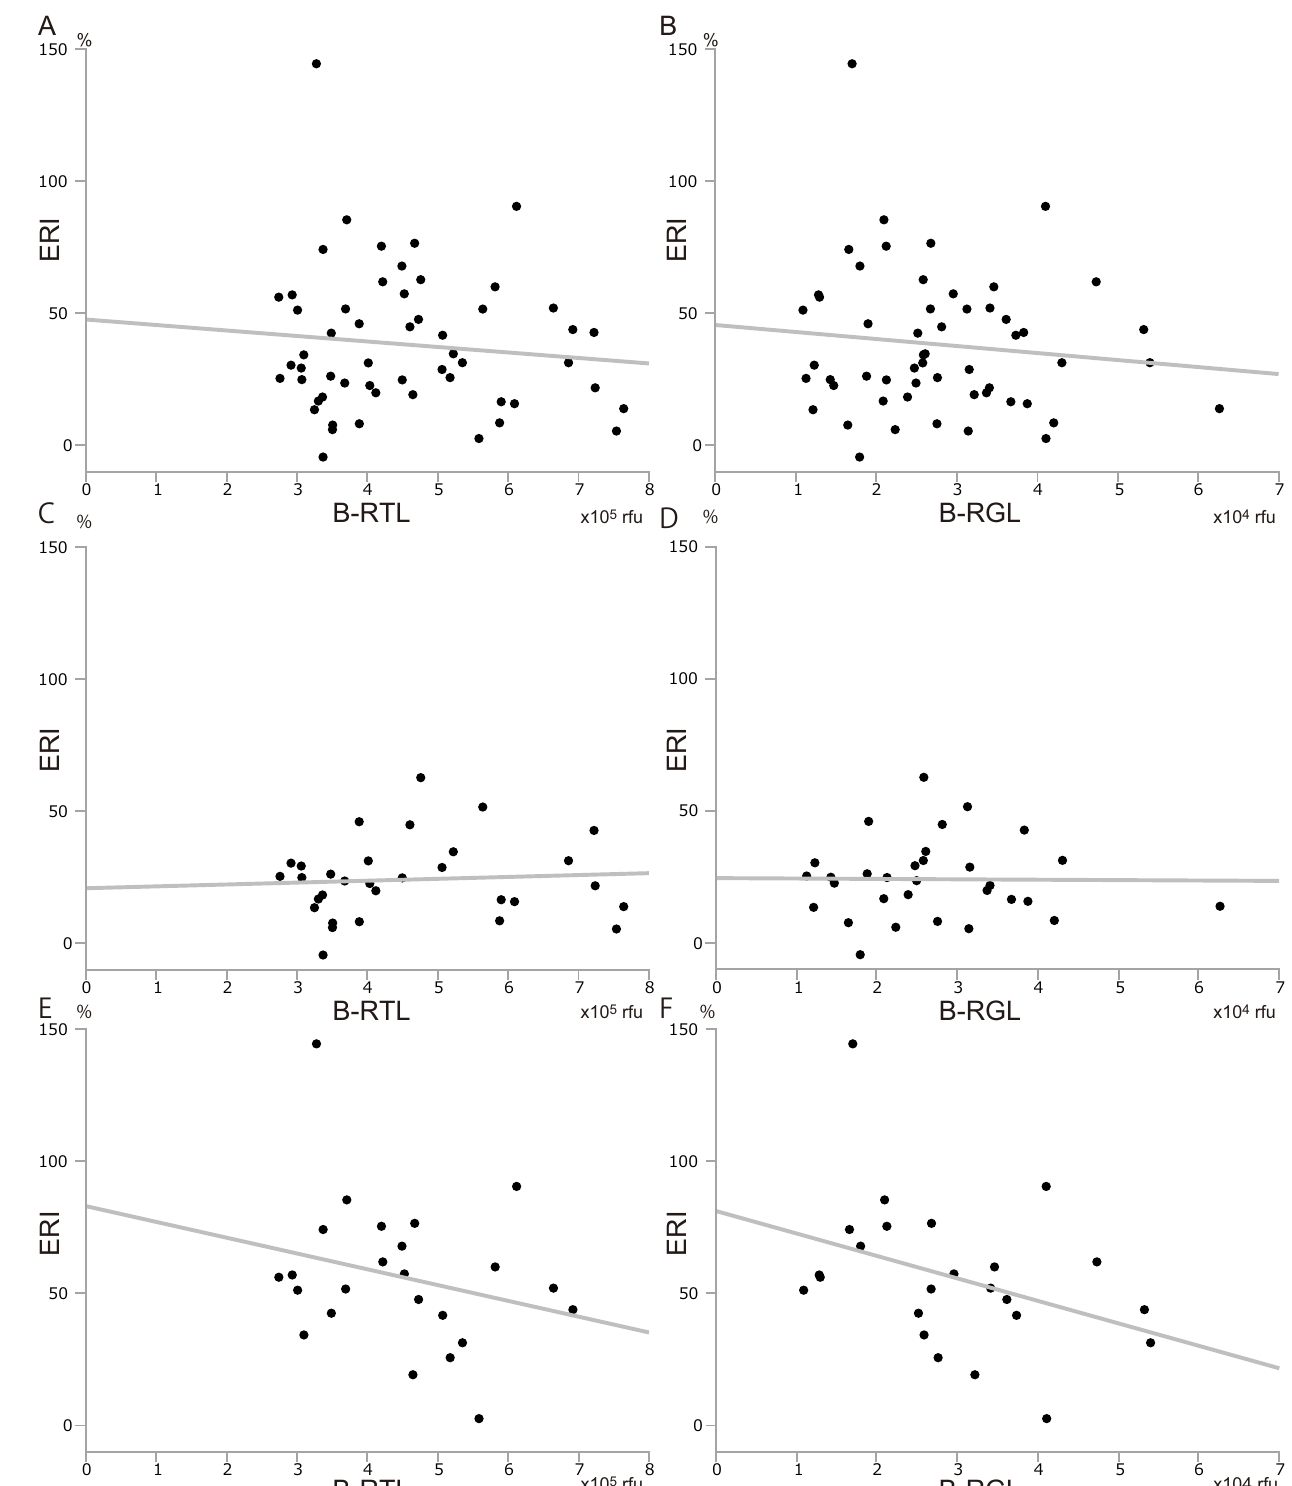
Fig 5. Correlation between telomere/G-tail length from blood and liver regeneration. (A) B-RTL and ERI in all donors (y = - 2.08 x + 47.6, r 2 = 0.011, p = 0.440). (B) B-RGL and ERI in all donors (y = - 2.65 x + 45.6, r 2 = 0.013, p = 0.403). (C) B-RTL and ERI in donors who underwent left hemihepatectomy